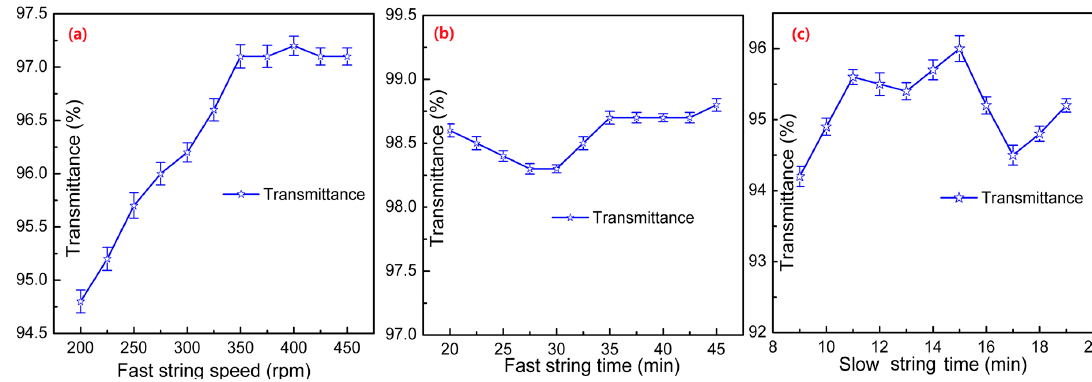
Figure 6. Effect of ( a ) fast stirring speed, ( b ) fast stirring time, and ( c ) slow stirring time on transmittance.